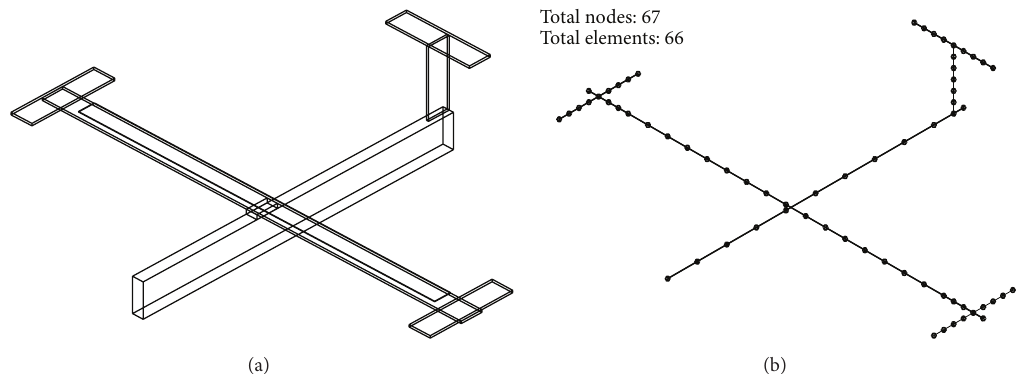
Figure 8: A simplified GARTEUR plane model. (a) GARTEUR plane model. (b) Finite element model of the GARTEUR plane.